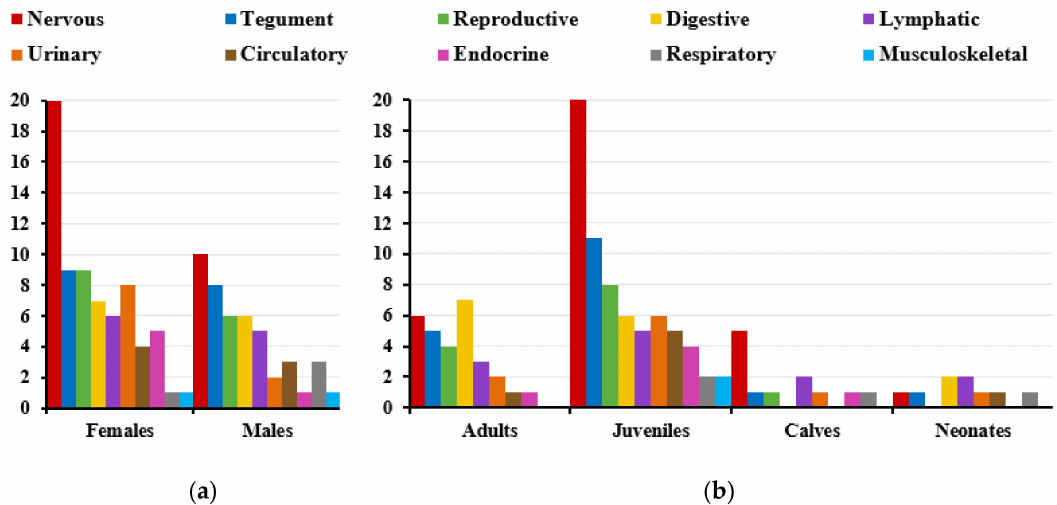
Figure 2. Number of tissues in each organ system that tested positive to HV DNA, stratified by sex ( a ) and age ( b ) of the animal. HV DNA was detected in 121 of 966 tissue samples (12.53%), which had the following distribution by sex and age: females (70/439, 15.94%), males (45/498, 9.04%), adults (29/377, 7.69%), juveniles (69/379, 18.21%), calves (12/83, 14.46%), and neonates (9/98, 9.18%).